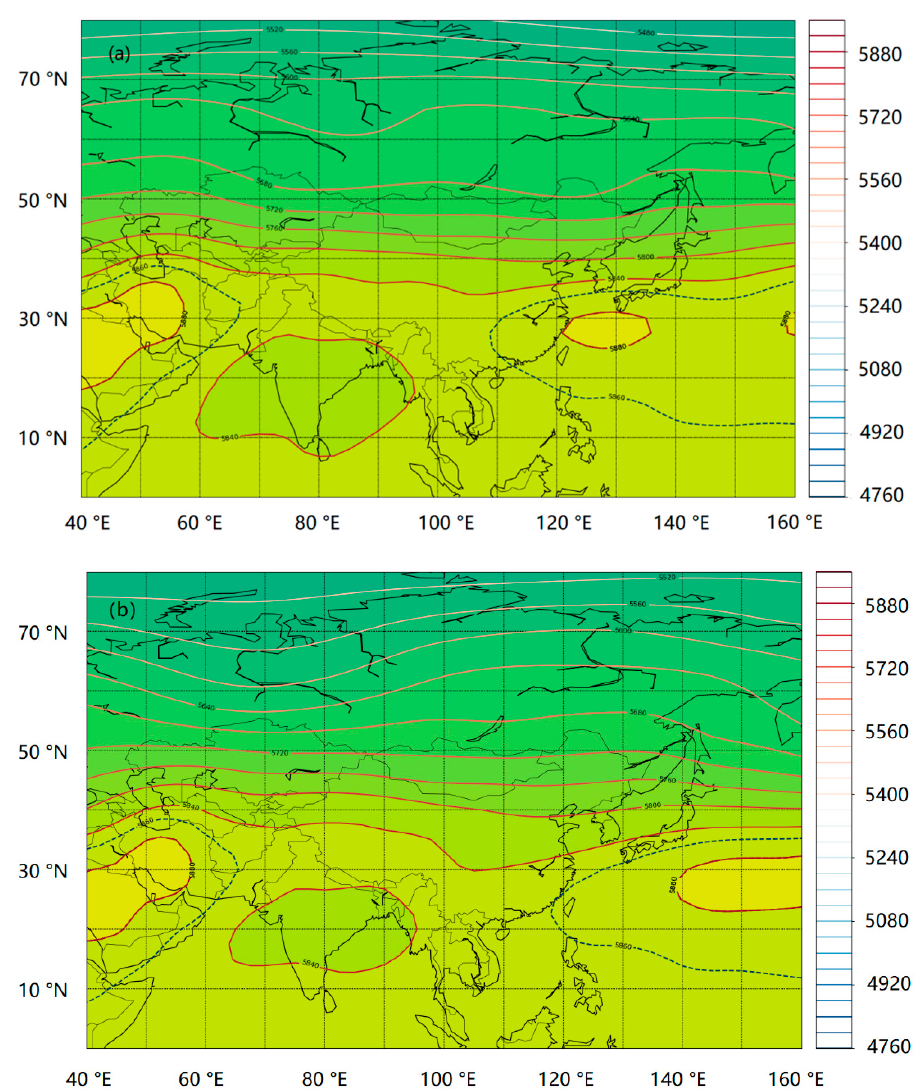
Figure 11. Calculated mean 500-hPa height field (geopotential) in July in typical years with ( a ) more and ( b ) fewer EMTEs in East China.